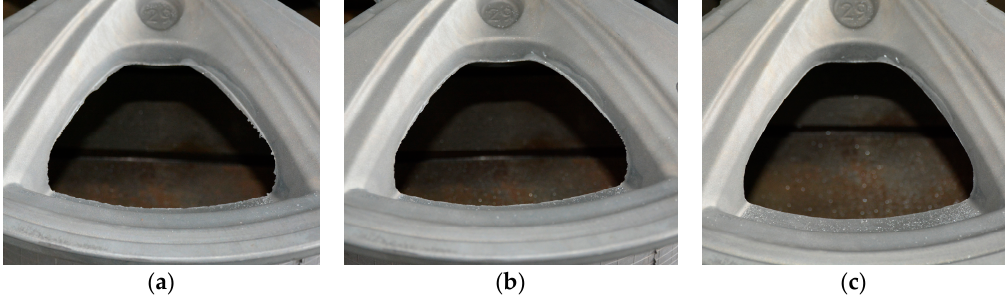
Figure 17. Results of layered experimental deburring disc of hub: ( a ) first layered deburring; ( b ) second layered deburring; ( c ) third layered deburring.